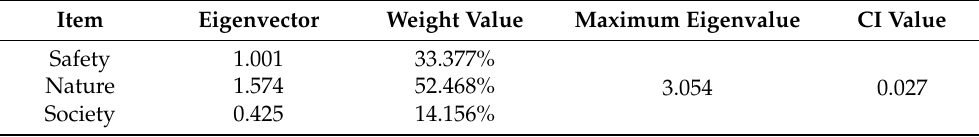
Table 9. Results of hierarchy analysis of suitability of construction land.